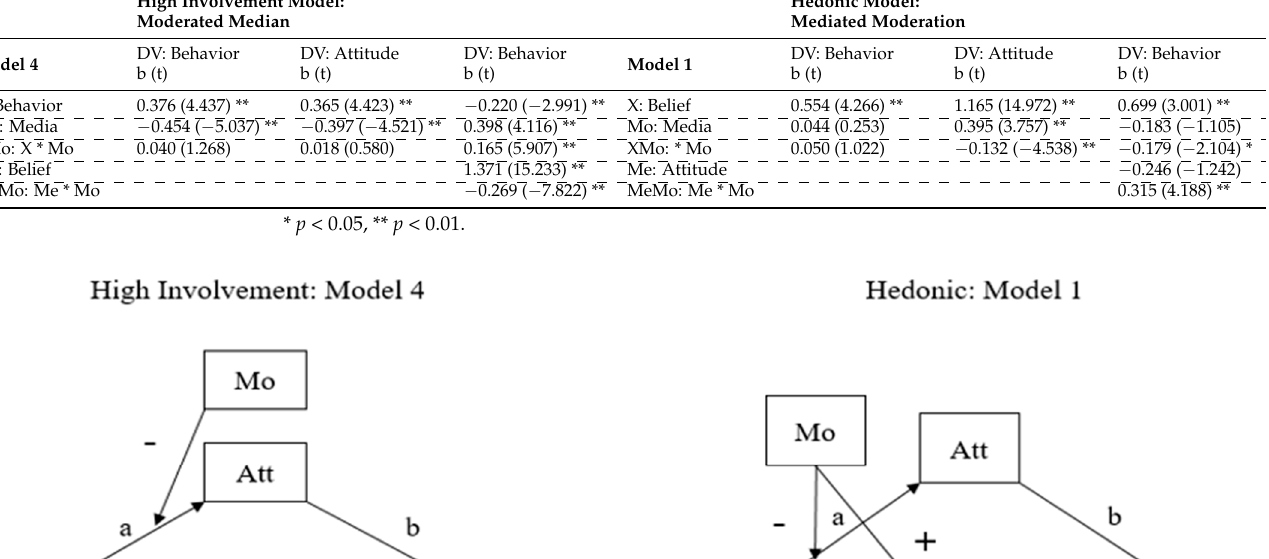
Figure 8. Media Trust Model in Korea. Table 8. Media Trust Model in Japan.